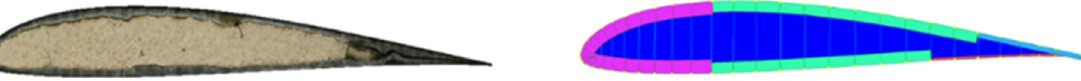
Fig. 3. Blade model.